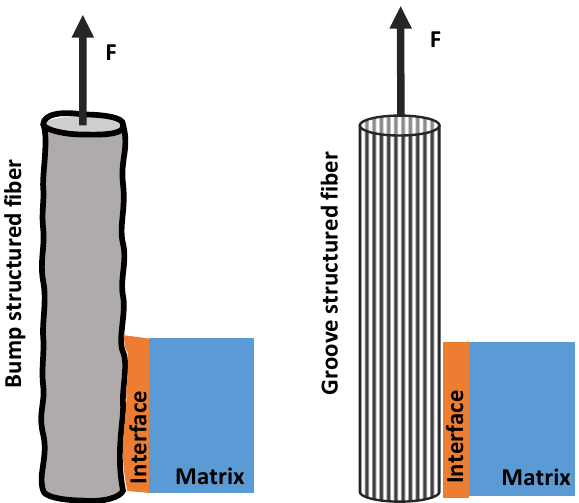
Figure 7. Schematic mechanism diagram of single fiber with different surface microstructure pull out from the matrix.